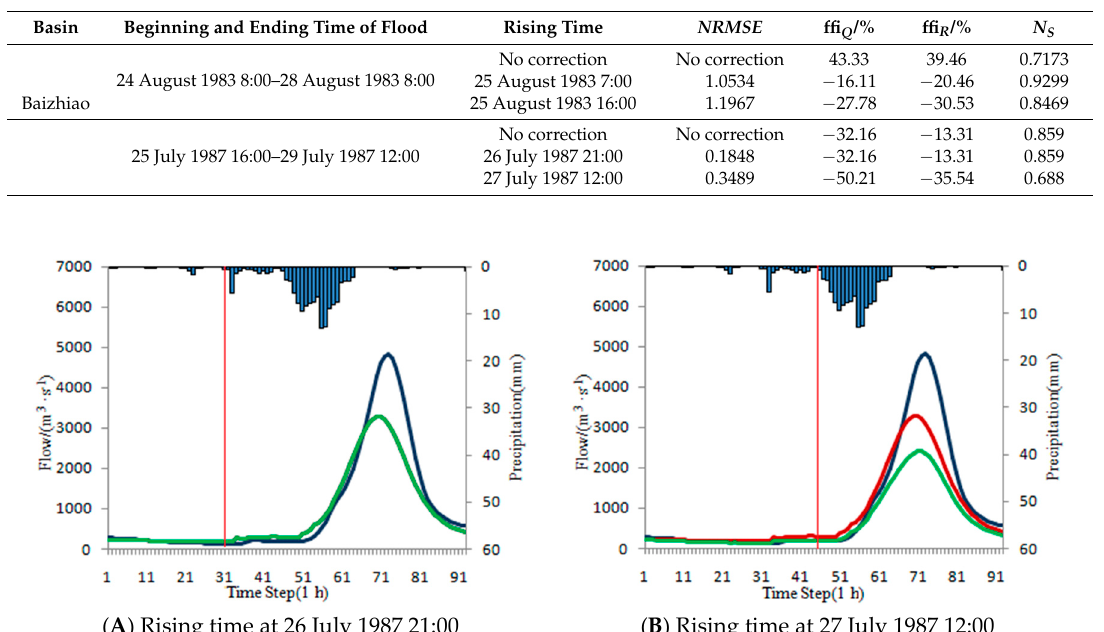
Table 23. Different results of flood correction under different steady periods.